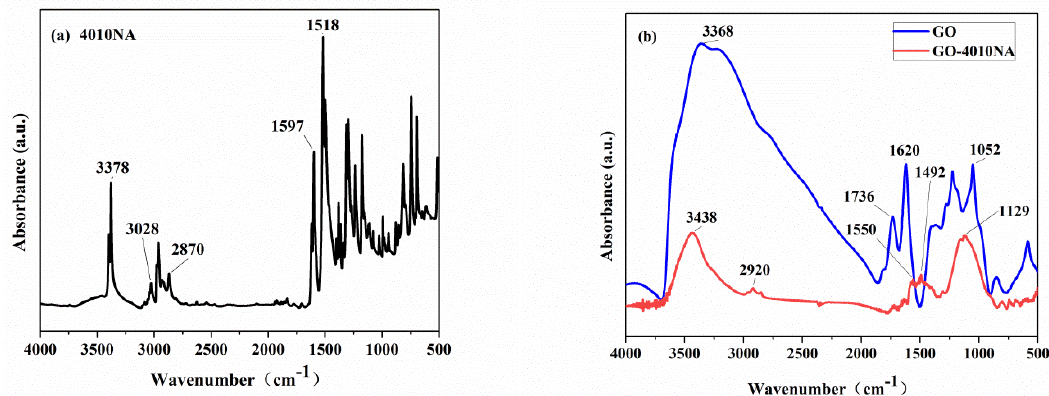
Figure 4. FTIR spectrum of ( a ) 4010NA and ( b ) GO and GO-4010NA.